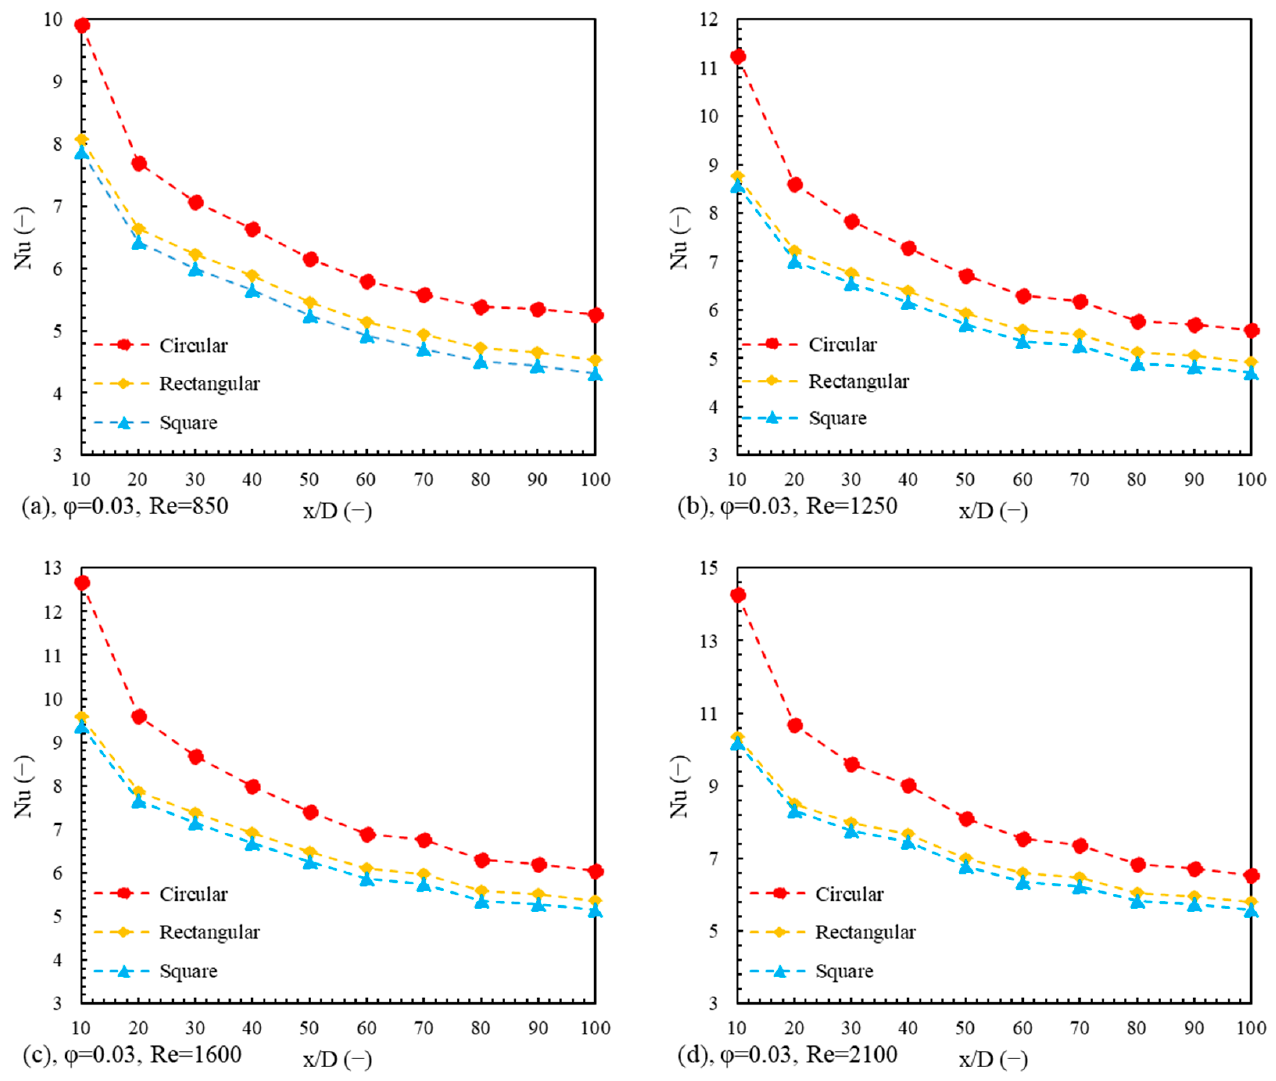
Figure 6. Local Nu of 3% nanofluid with different cross-sections in ( a ) Re = 850, ( b ) Re = 1250, Figure 6. Local 𝑁𝑢 of 3% nanofluid with different cross-sections in ( a ) 𝑅𝑒 = 850 , ( b ) 𝑅𝑒 = 1250 , ( c ) Re = 1600, and ( d ) Re = ( c ) 𝑅𝑒 = 1600 , and ( d ) 𝑅𝑒 = 2100 .